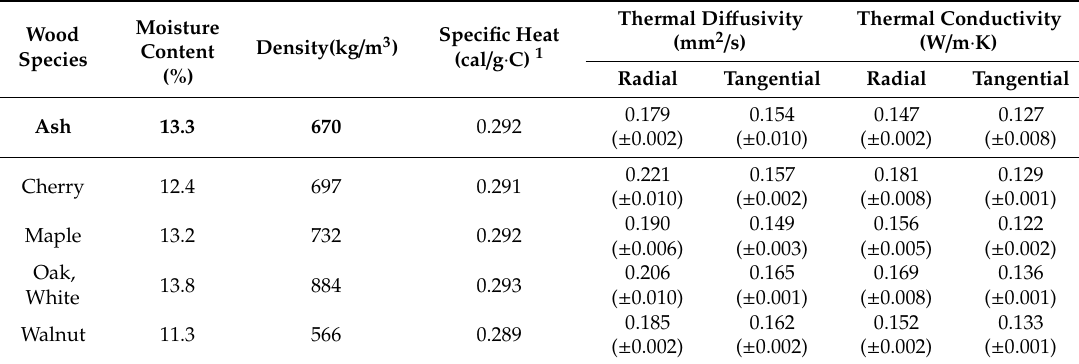
Table 2. Thermal di ff usivity and conductivity of wood species in radial and tangential directions.